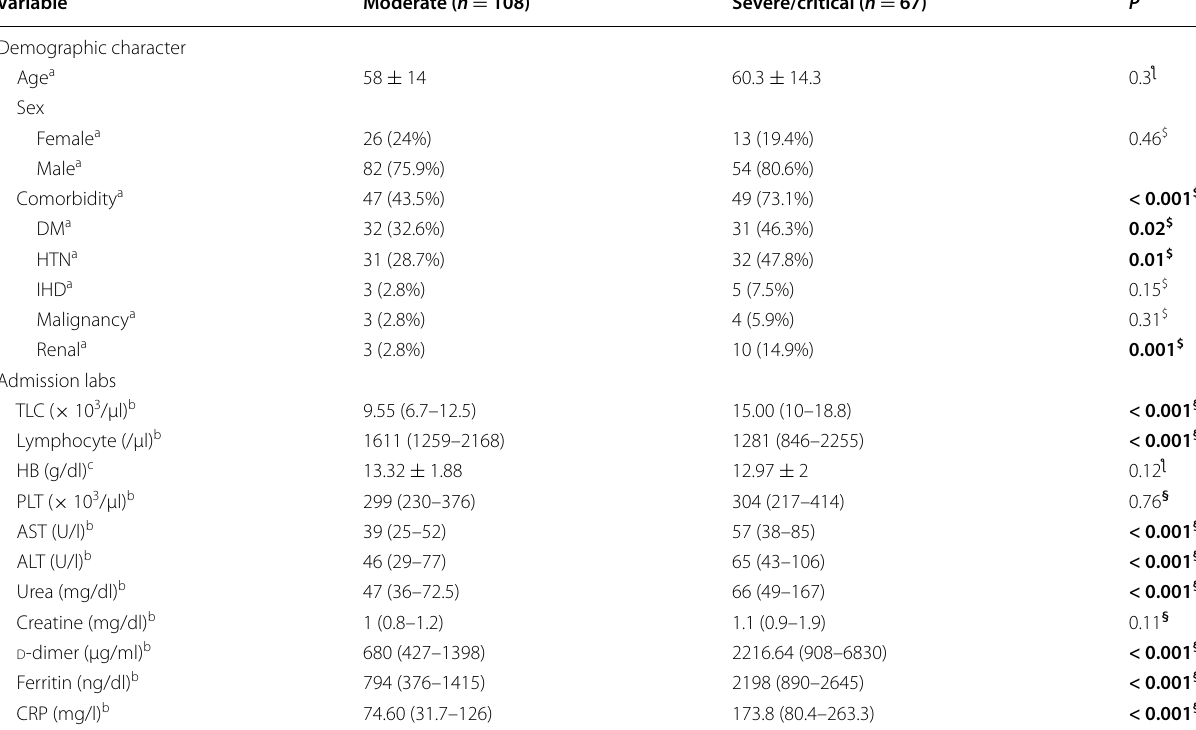
Table 2 Univariate Cox analysis of the risk factors for the severity of